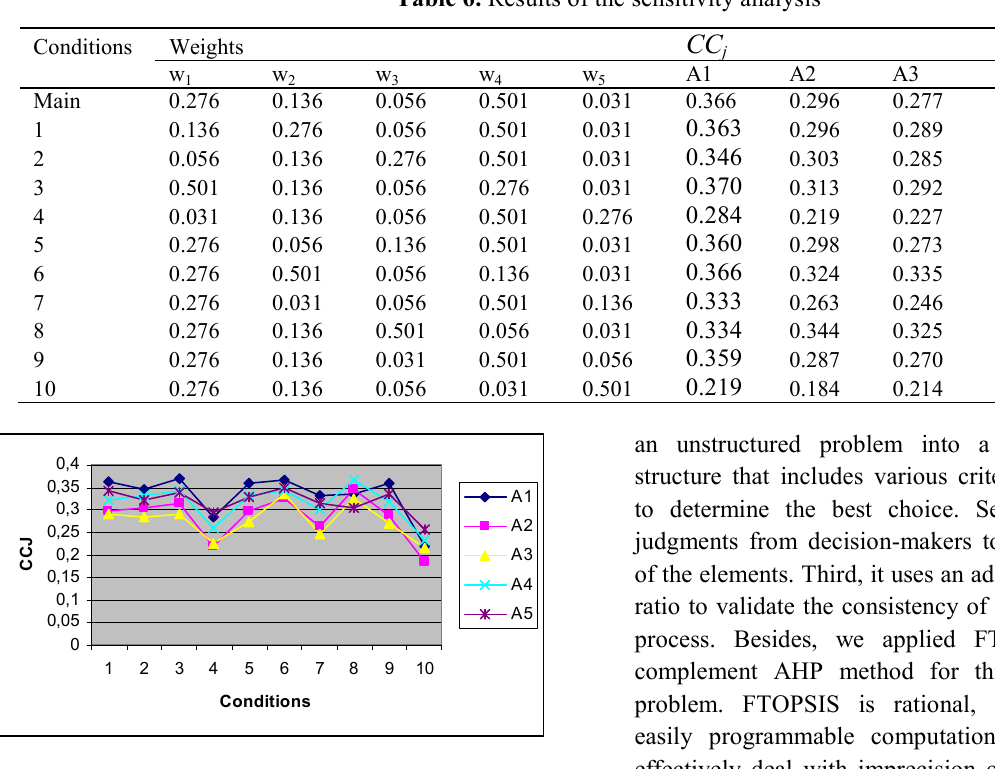
Table 6. Results of the sensitivity